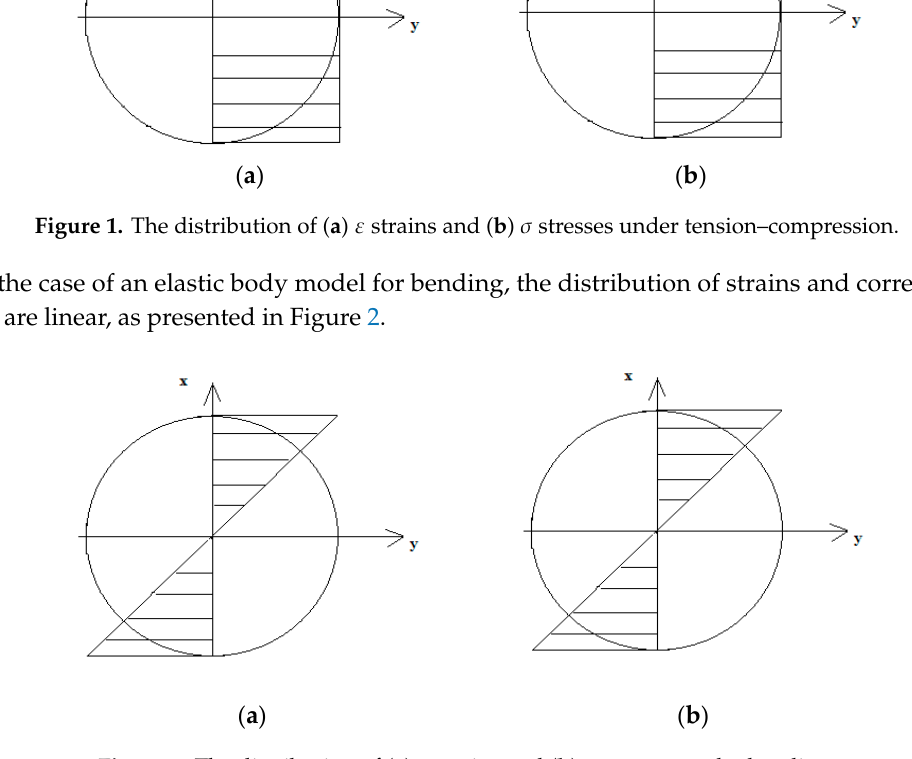
Figure 2. The distribution of ( a ) 𝜀 strains and ( b ) σ stresses under bending.